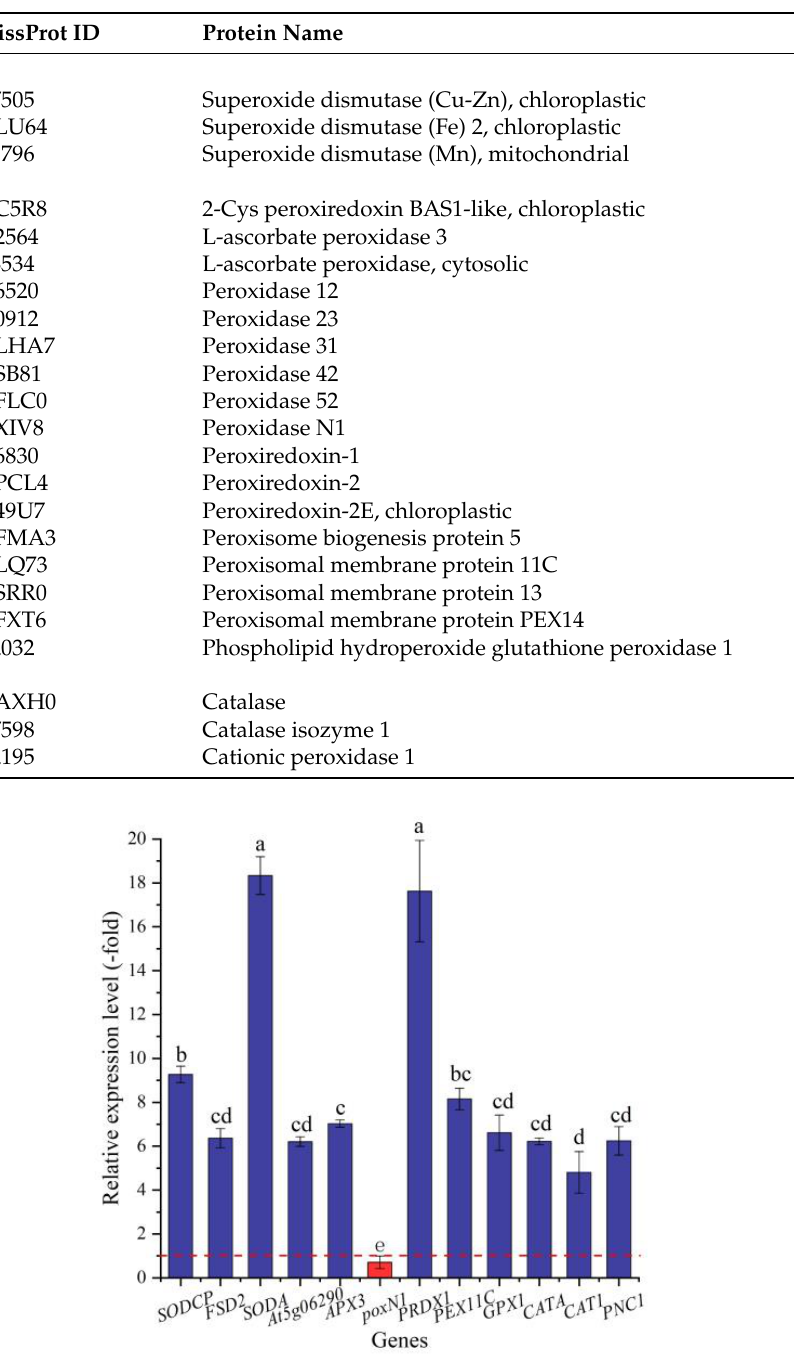
Table 3. Twenty-three genes directly associated with antioxidant enzymes at the 300 mmol/L NaCl vs. CK.